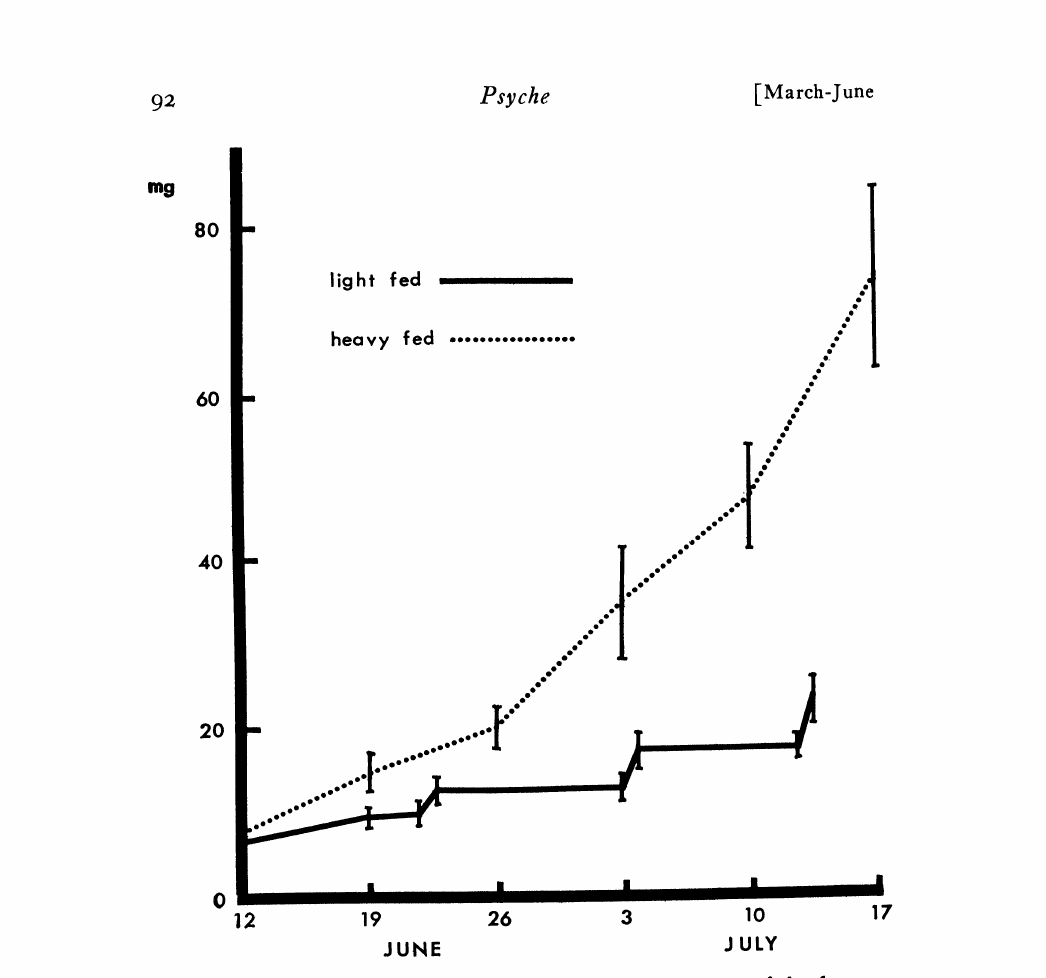
Figure 1. Mean weights of 19 light-fed and 15 heavy-fed .4raneus diadematus with standard errors (vertical lines). Figures are for both sets of spiderlings combined,. Sharp increases in weight in the group are due to the animals being weighed before and after feeding. Note the increasing difference in weight between the light-fed and heavy- fed